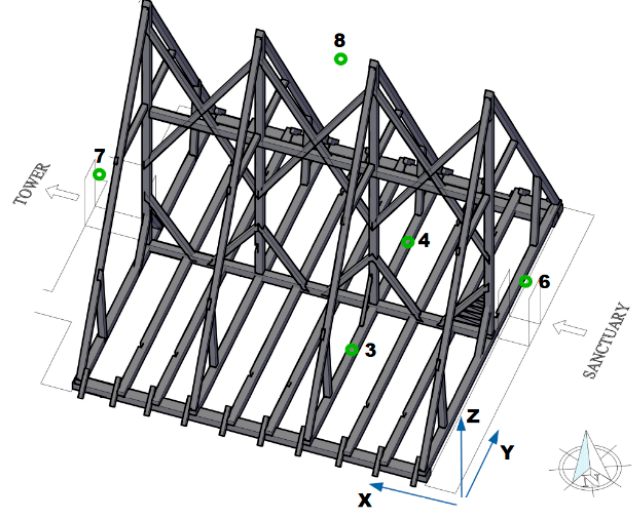
Figure 3. Side view of the truss over the nave with the location of the measuring points. The arrows indicate the openings to the tower and the truss above the sanctuary.